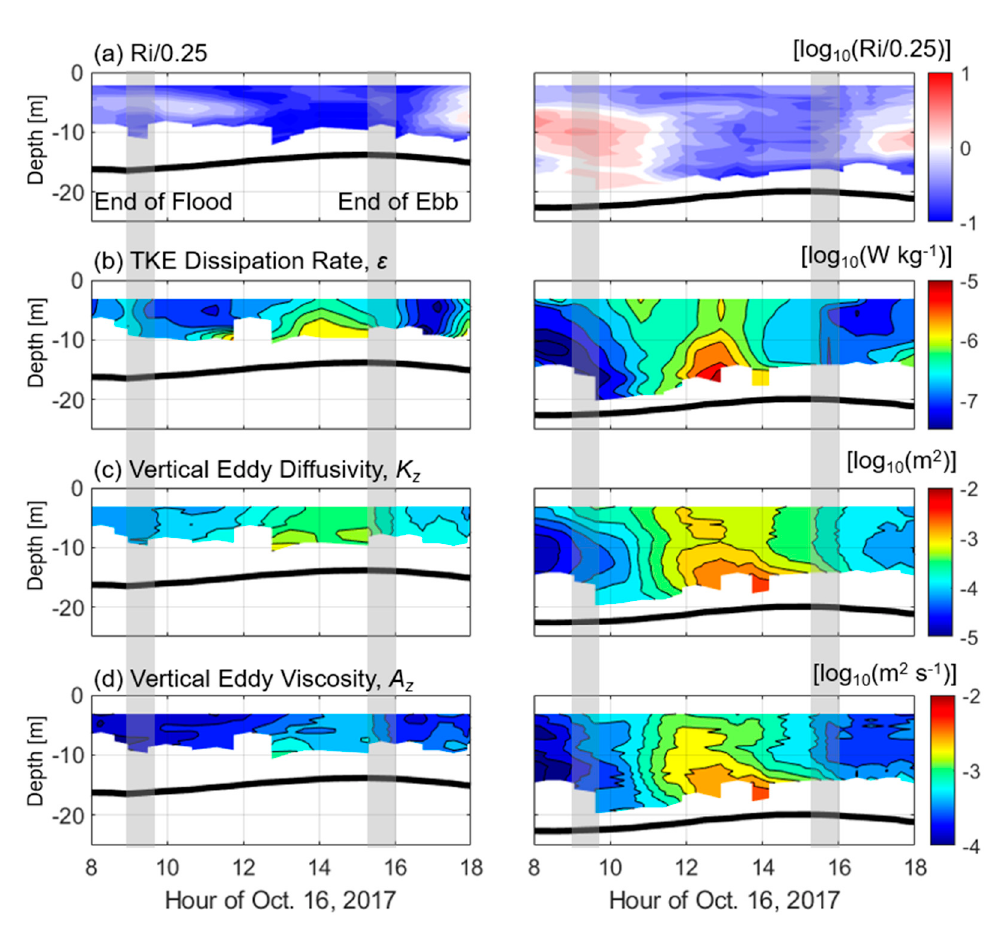
Figure 5. At stations 1 (left panels) and 2 (right panels): ( a ) Gradient Richardson number, Ri , divided by 0.25 (values less than 0 indicate Ri < 0.25). ( b ) TKE dissipation rate, ε . ( c ) Vertical eddy diffusivity, K z . ( d ) Vertical eddy viscosity, A z . Hour of 16 October 2017 is the x axis of each subplot, and depth is the y axis. All panels show log 10 values. Shaded boxes represent the end of flood and ebb tides.